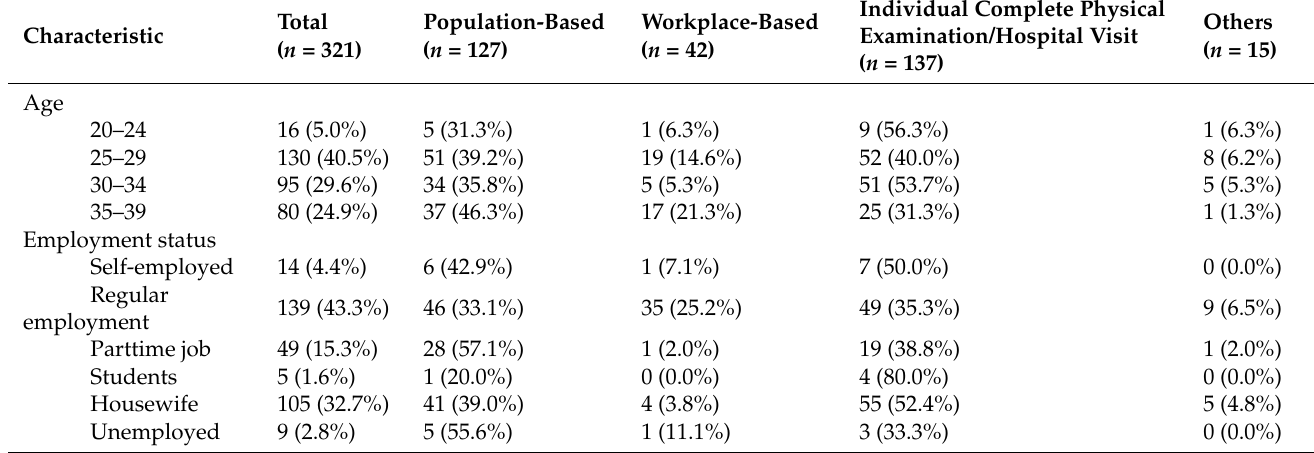
Table 2. Status of participation in